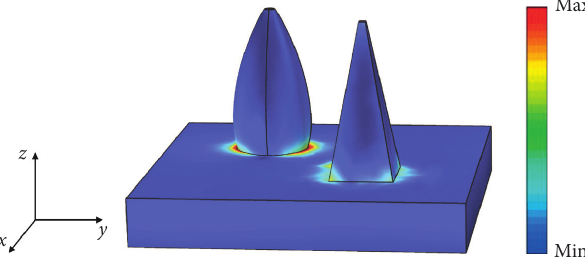
Figure 18: Field concentration in the arrangement of nanoantennas for normal incidence.